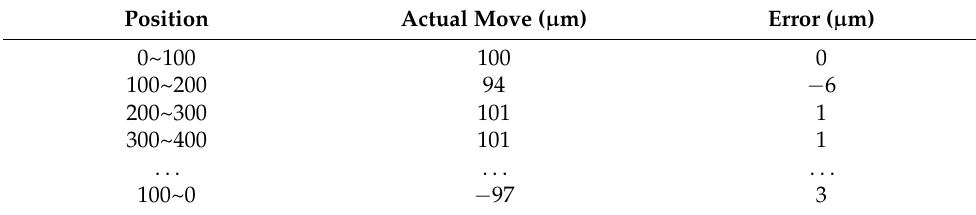
Table 1. Positioning data set for XXY platform errors.